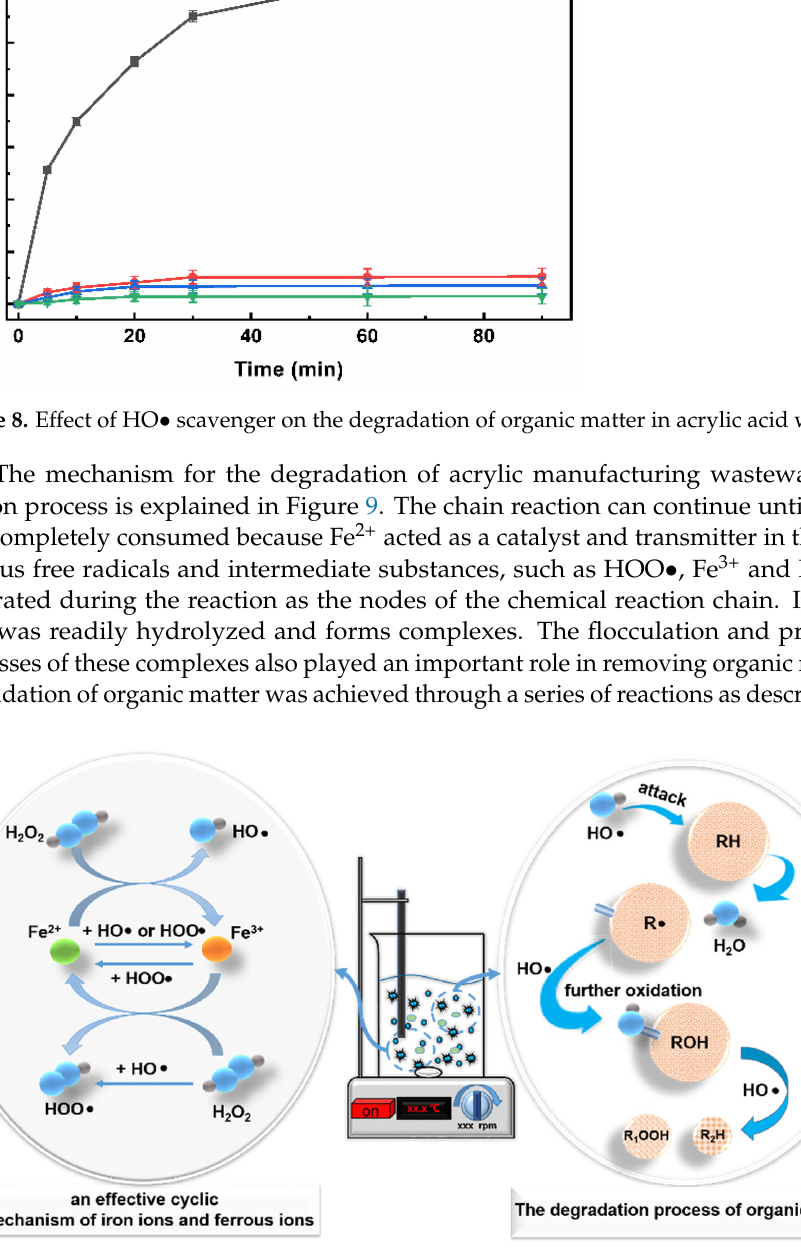
Figure 9. Schematic diagram of Fenton reaction process.